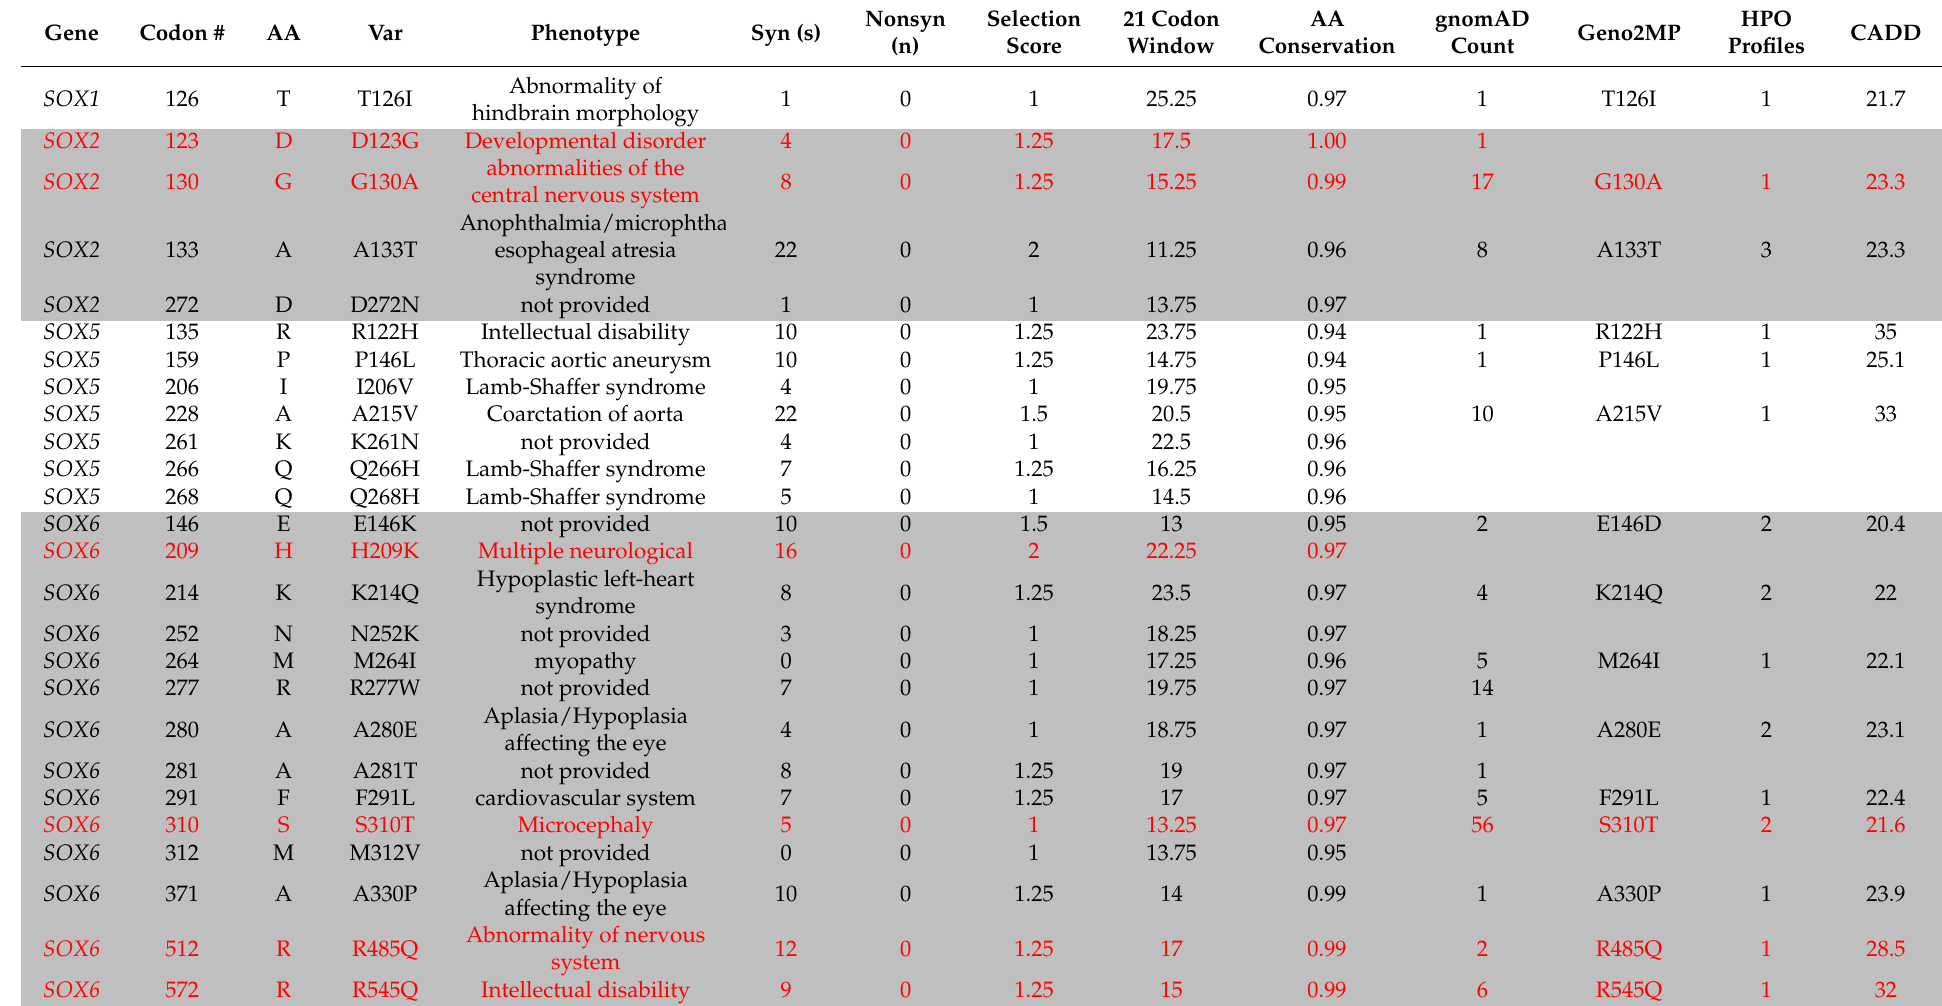
Table 5. High-ranking SOX protein variants found outside the HMG box. Red text are those that have matching phenoptypes or are of high interest. Rotating white to gray indicates different SOX genes with multiple variants for